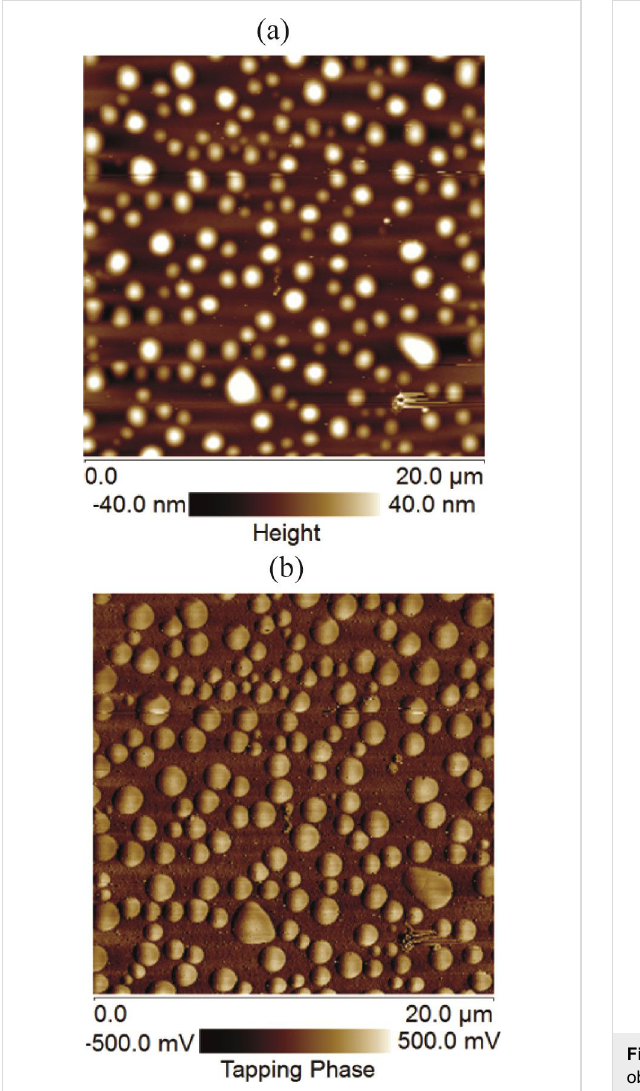
Figure 8: (a) Height image of spherical domains. (b) Phase image of spherical domains. A clear phase contrast can be observed in the image.